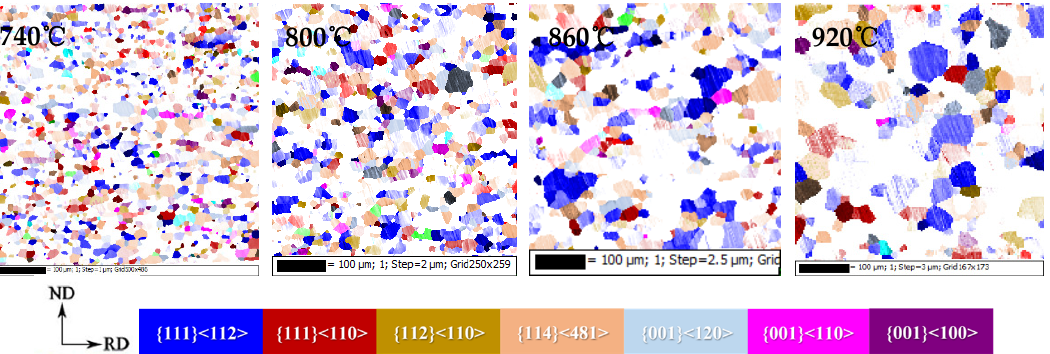
Figure 11. Texture component diagram during grain growth of Fe-0.65%Si non-oriented electrical steel annealed sheet.